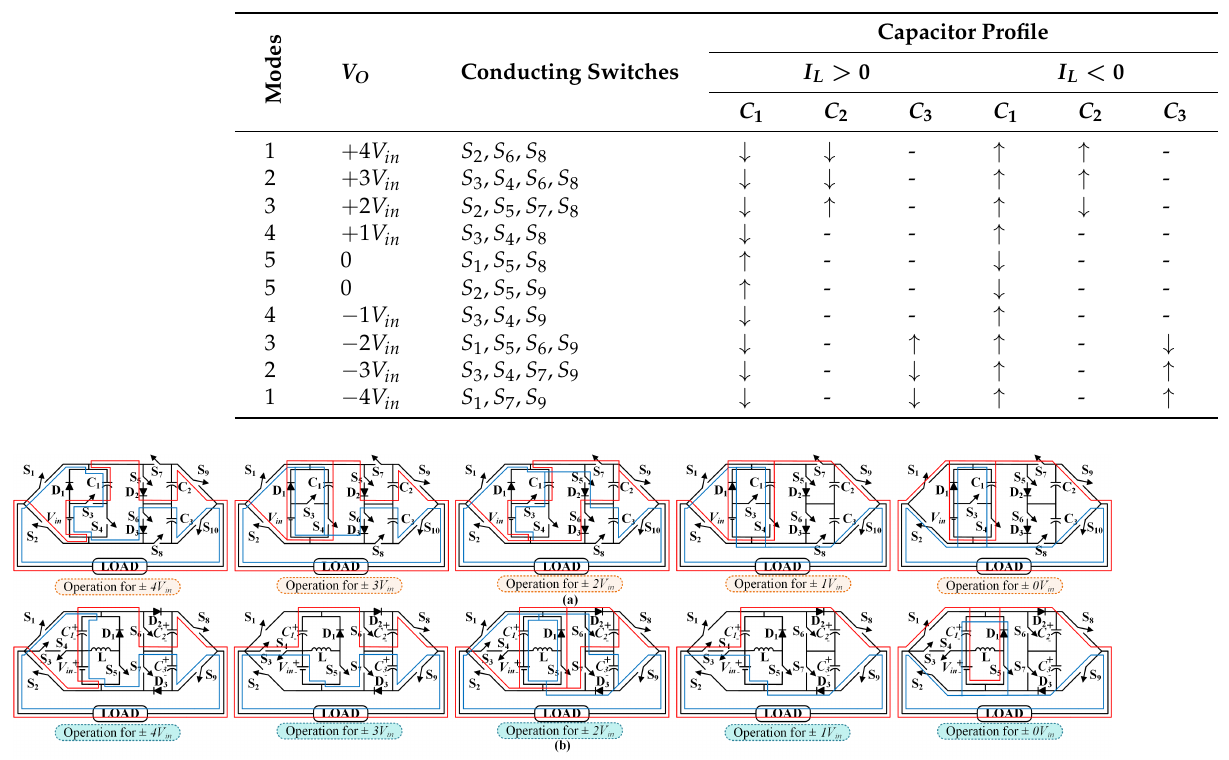
Figure 3. Modes of Operation for QBI ( a ) Topology 1, ( b ) Topology